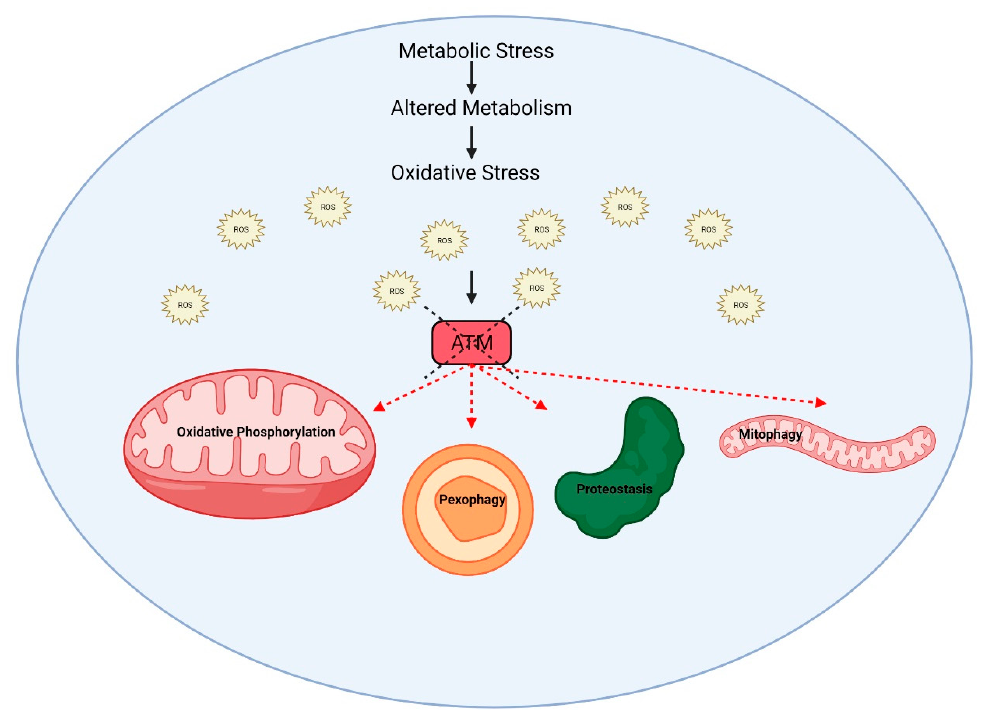
Figure 4. ATM has a broader role in regulating metabolism by modulating mitochondrial and peroxisomal enzymes involved in oxidative phosphorylation in fatty acid β - oxidation pathways. A-T